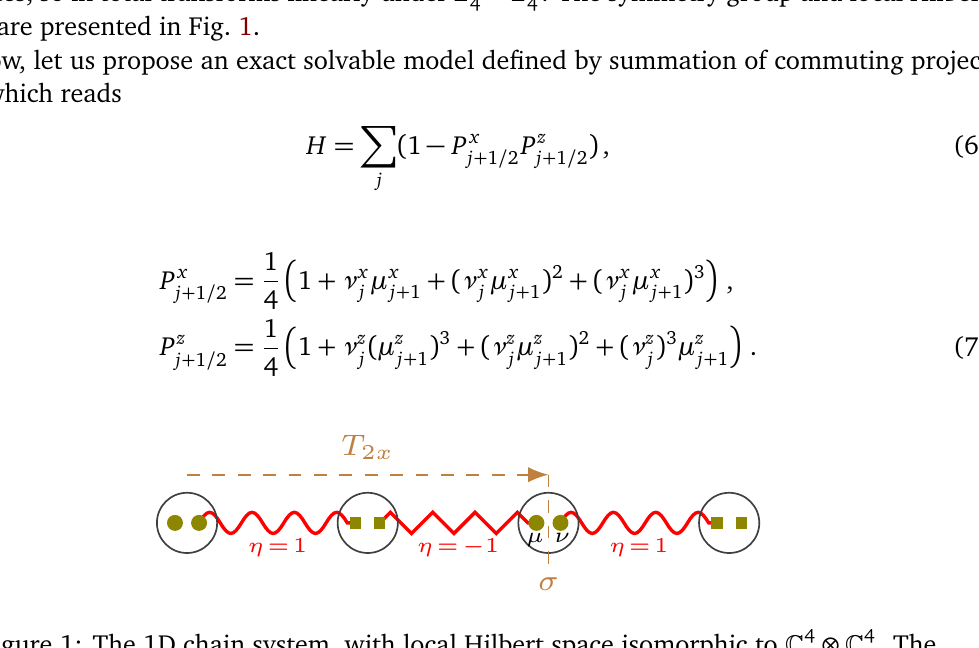
Figure 1: The 1D chain system, with local Hilbert space isomorphic to (cid:67) 4 ⊗ (cid:67) 4 .